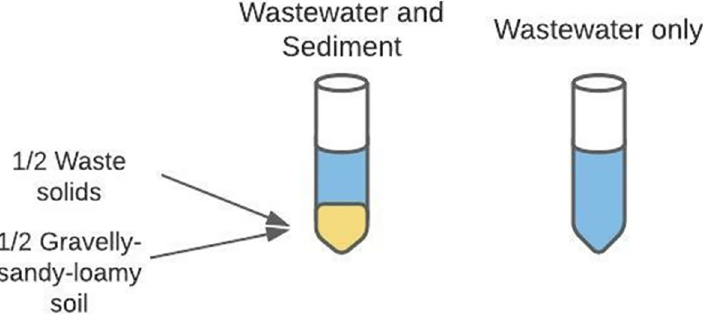
Fig 1. Microcosms evaluated in current study. Figure created using Microsoft